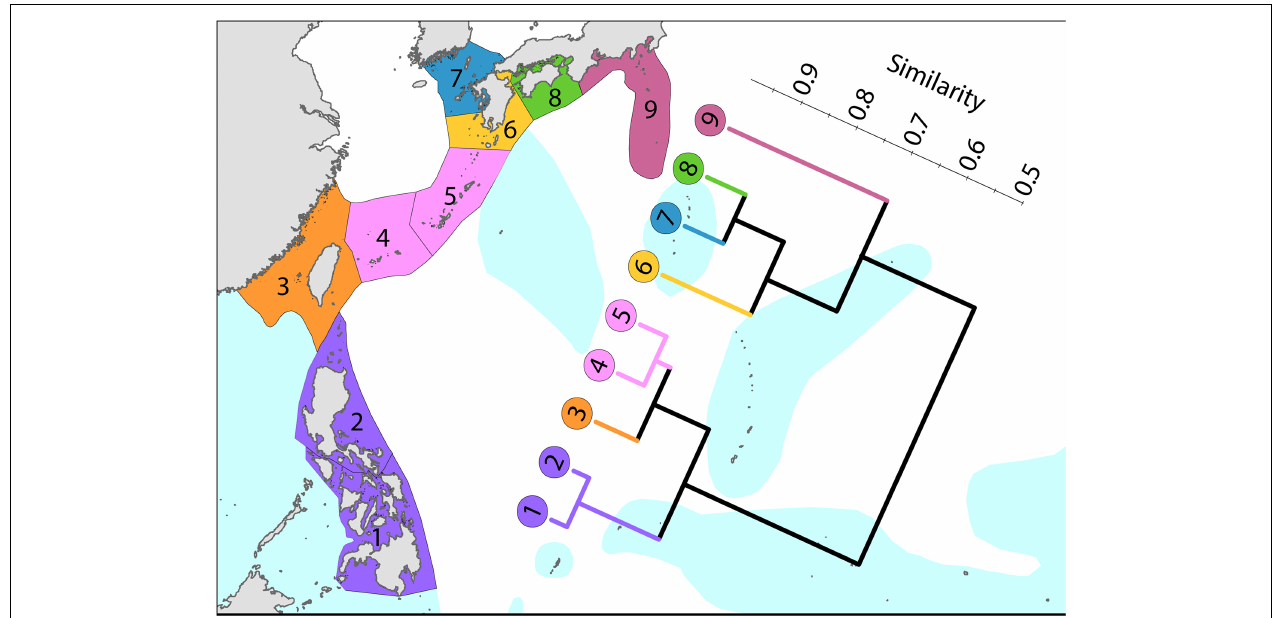
FIGURE 8 | Latitudinal attenuation of affinity and diversity of ecoregions along the path of the Kuroshio. Ecoregions in the Coral Triangle (numbered 1 and 2) are strongly delineated from other ecoregions. Ecoregions to the north with coral reefs (numbered 3–5) are strongly delineated from those without reefs (numbered 6–9). Ecoregions